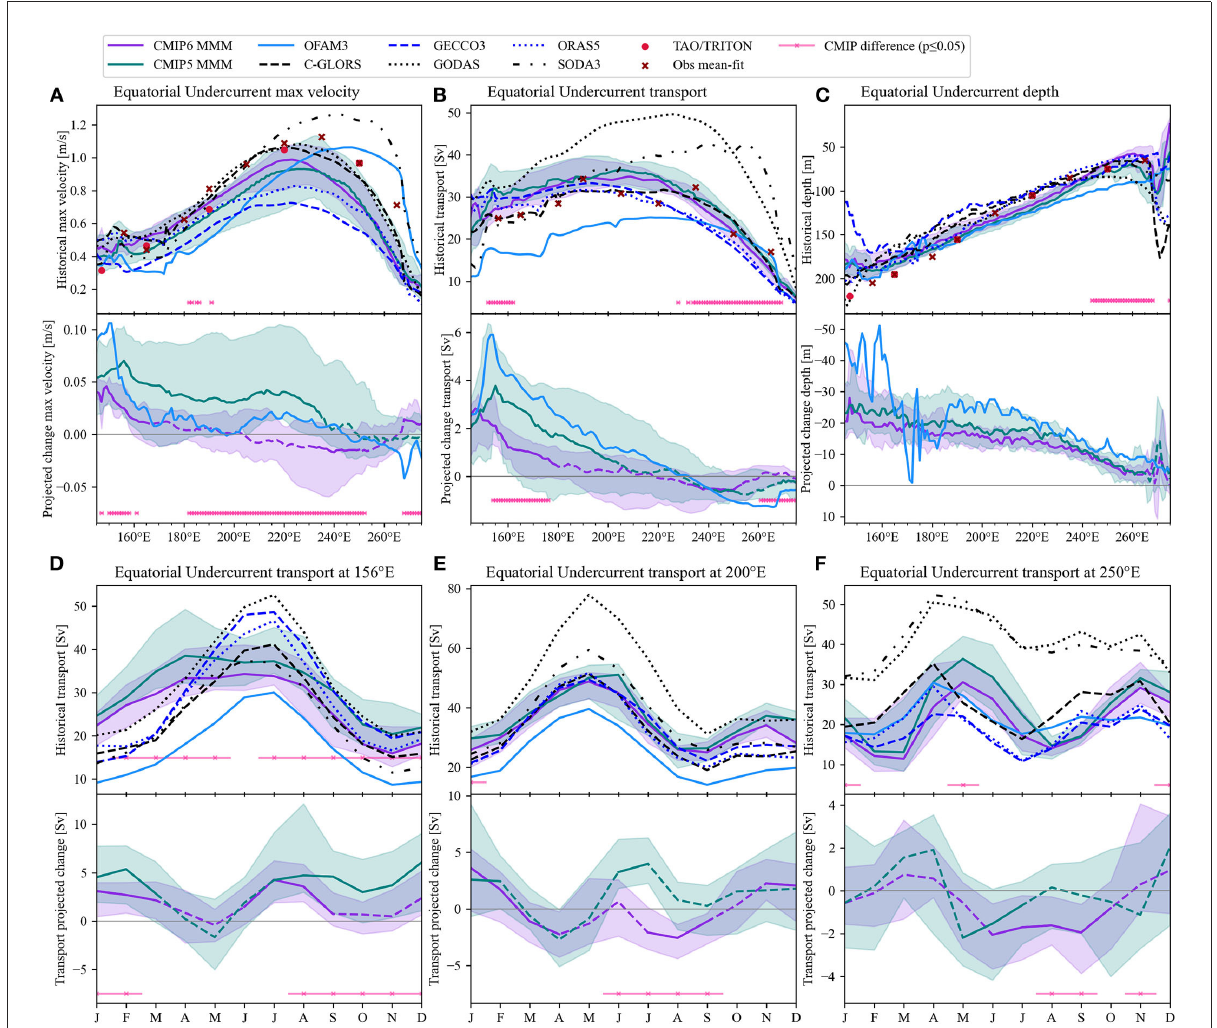
FIGURE2 Equatorial Undercurrent mean state and the future changes. The mean state (upper panels) and projected change (lower panels) for (A) maximum EUC velocity, (B) transport, (C) depth of maximum EUC velocity, and monthly mean transport at (D) 156 ◦ E, (E) 200 ◦ E, and (F) 250 ◦ E. Shown are CMIP6 (purple) and CMIP5 (green) multi-model median (MMM; solid lines) and interquartile range (shaded), OFAM3 (blue lines), reanalysis products (black/blue broken lines), TAO/TRITON moorings (red circles) and the Johnson et al. (2002) observational mean-fit (dark red crosses). In lower panels, dashed lines indicate where MMM projected changes are not significant. Pink crossed lines indicate where CMIP5 and CMIP6 differences are